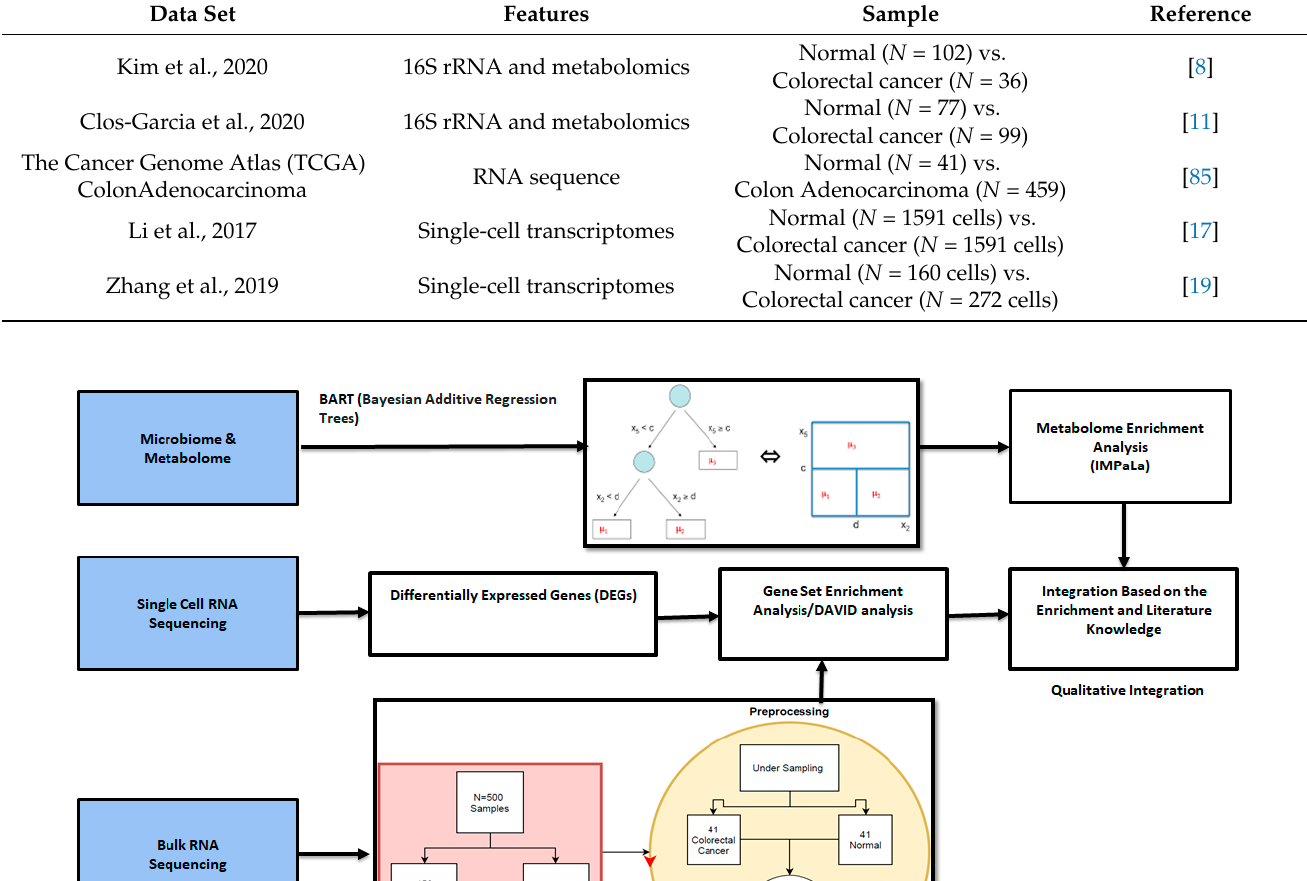
Table 2. Description of the microbiome, metabolome, bulk RNA sequencing and single cell sequencing datasets.